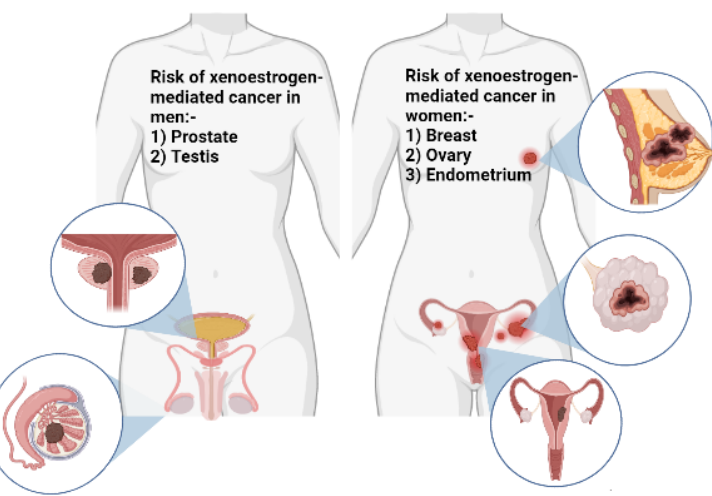
Figure 2. Risk of various estrogen-mediated cancers with xeno-estrogenic pesticide exposure.